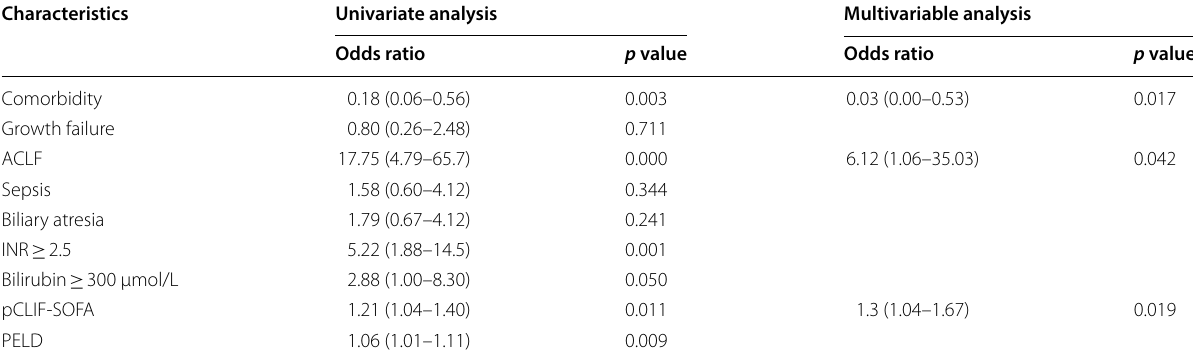
22) versus survival without ( n =